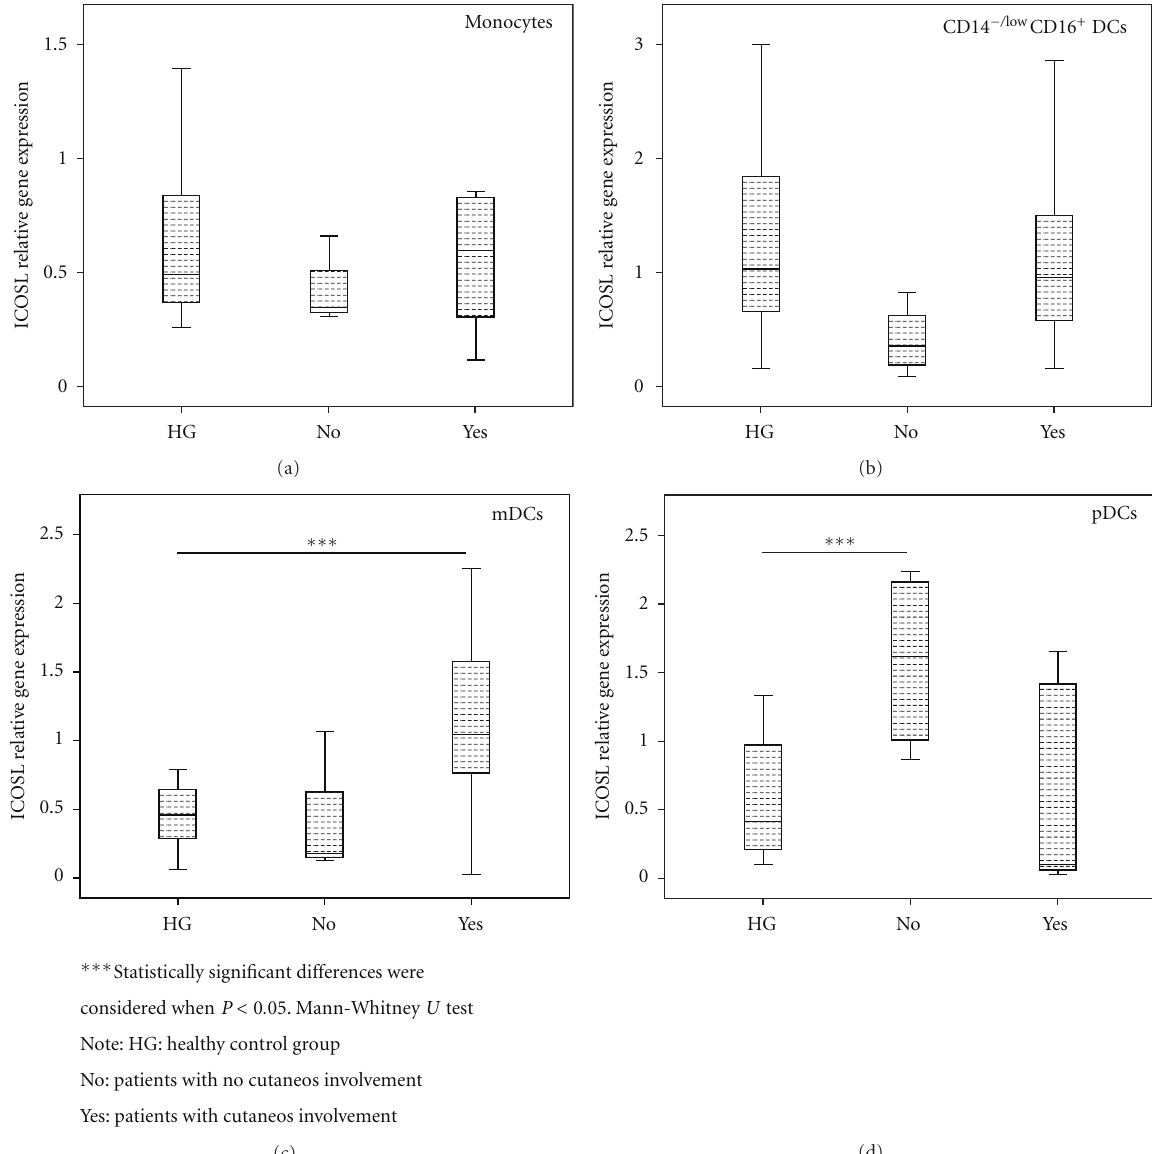
Figure 7: ICOSL relative gene expression in cell-sorted monocytes and DCs subsets, according to the cutaneos involvement of SLE patients.